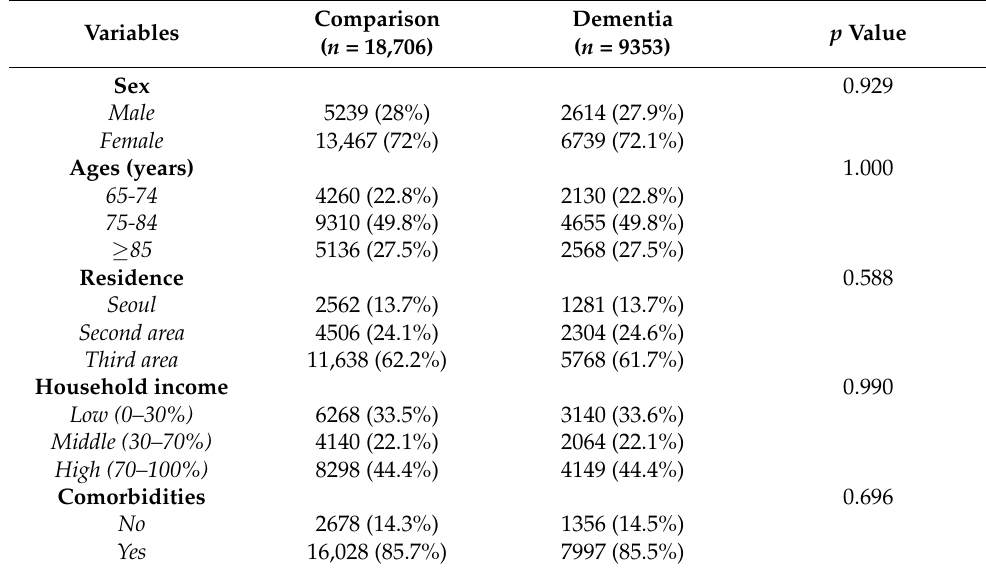
Table 2. Detailed characteristics of the cohort dataset for sensitivity